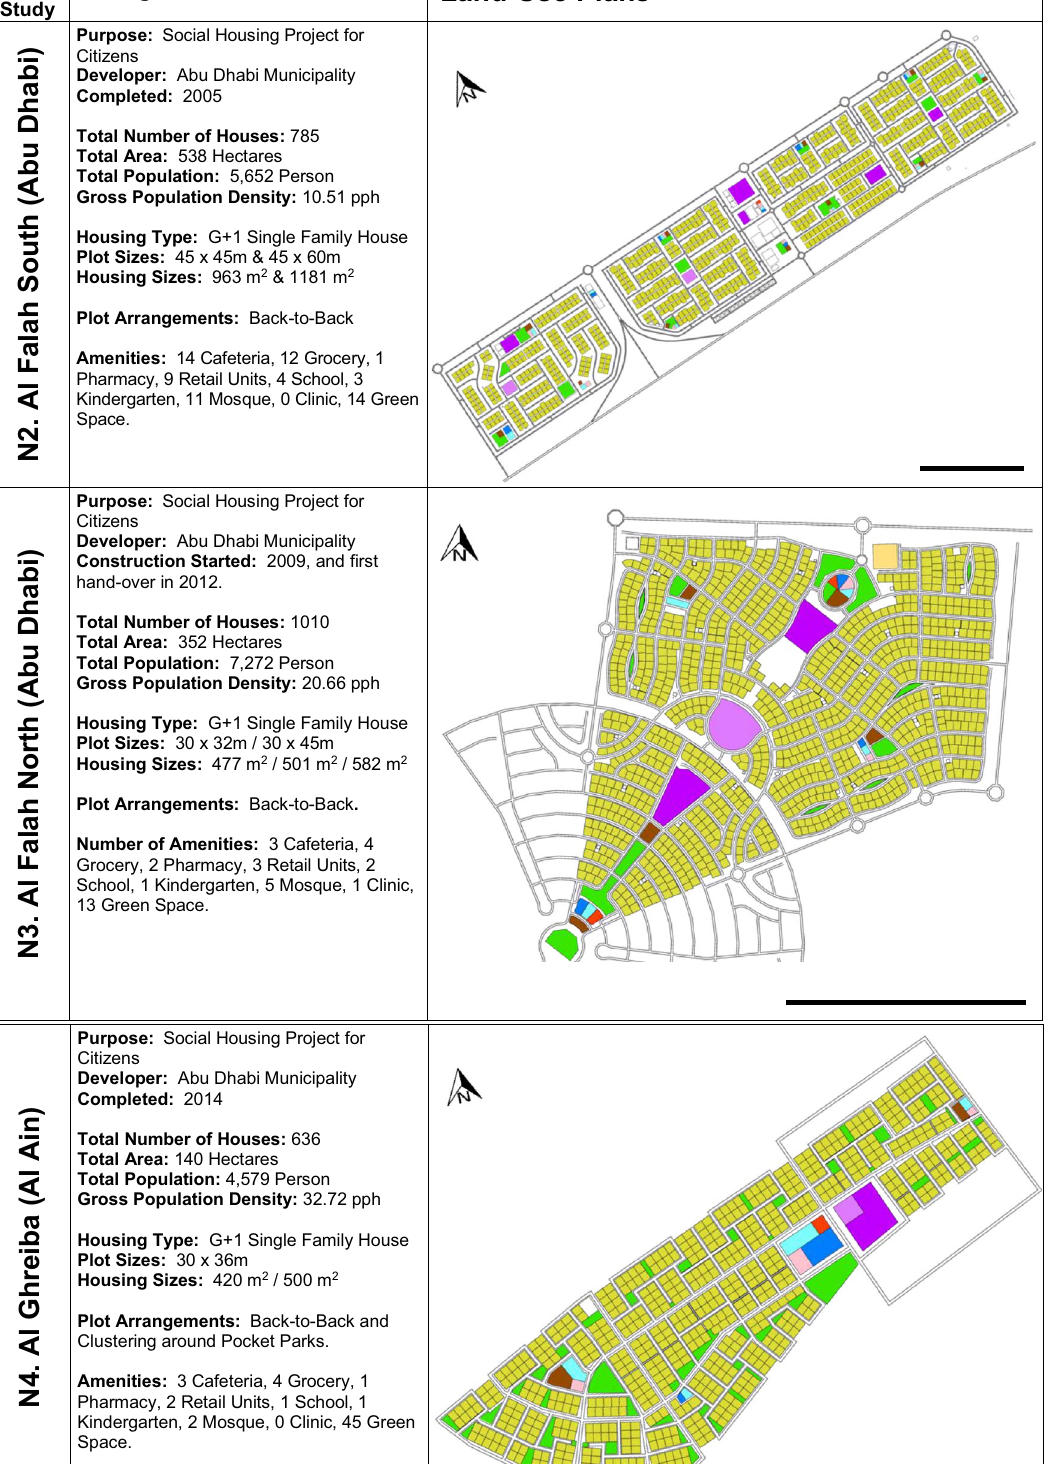
Table 3 The land-uses and urban characteristics of the selected case studies Case